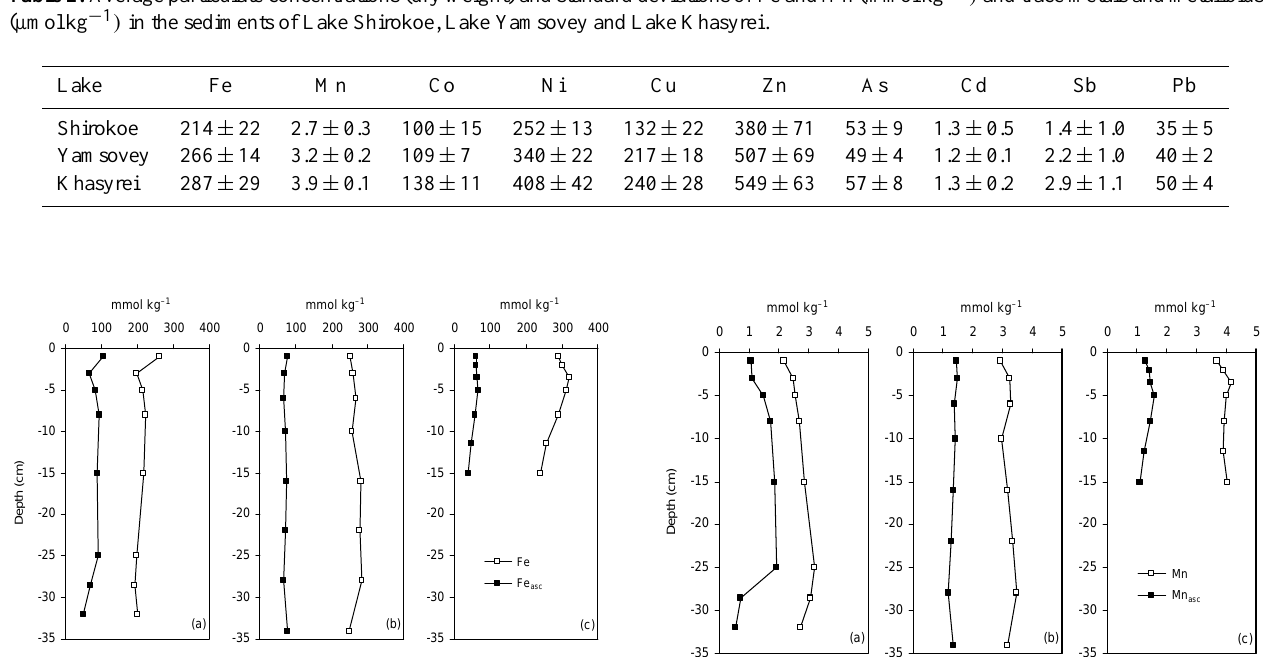
can be divided in two groups: (i) Co, Ni, Cu, Zn and As showing concentration–depth profiles very similar to that of Fe with first an increase of concentrations in the three first centimeters below the WSI and then a decrease; (ii) Cd, Sb and Pb showing steady concentration decrease with depth, particularly Sb dropping from 5.1 µmol kg − 1 below the WSI to 1.8 µmol kg − 1 at the bottom of the core. From the young (3rd) to the final (5th) stage of lake development, an in- creasing number of trace elements are associated with Fe ( R 2 ≥ 0.7) (Table 3): Cu (actively growing Lake Shirokoe), Co, Ni, Cu (mature Lake Yamsovey), and Co, Ni, Cu, Zn and As (drained Lake Khasyrei). In contrast, only Co in Lake Shirokoe and Pb in Lake Yamsovey show significant associ- ation with